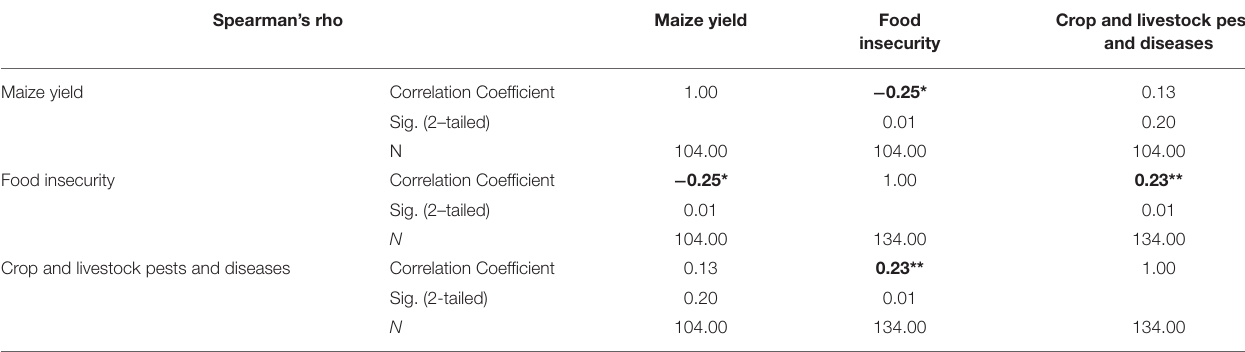
TABLE 3 | Correlations between livelihood stressors/outcomes variables.